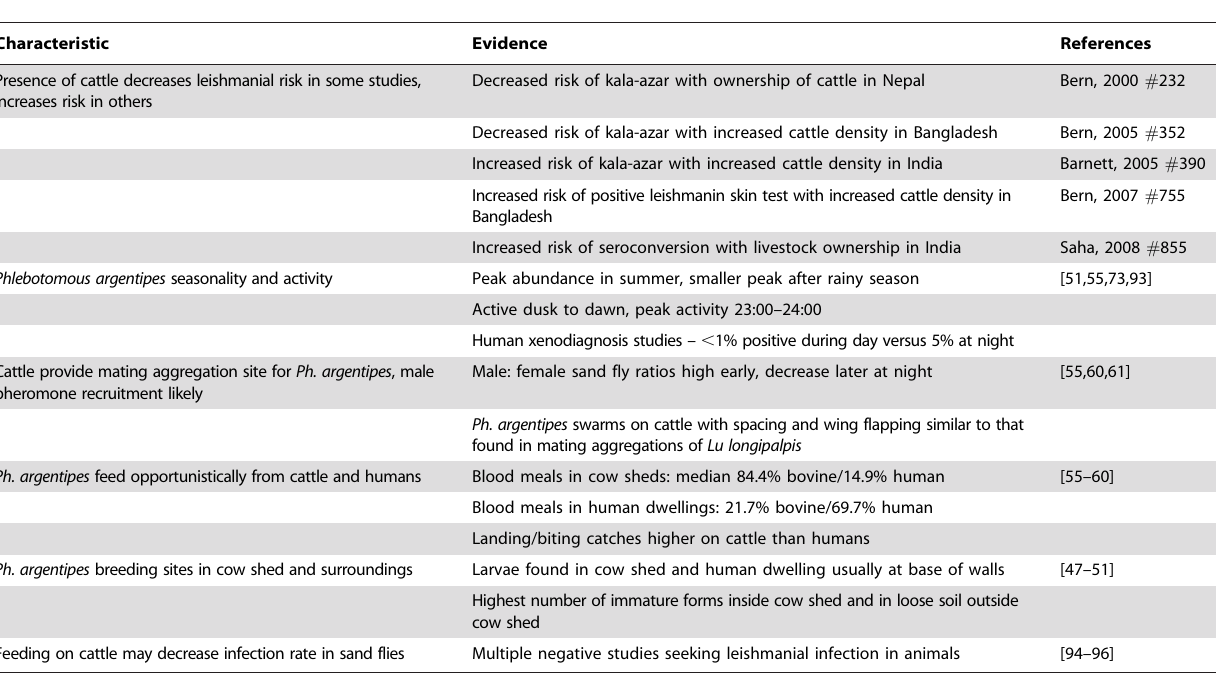
Table 2. Phlebotomous argentipes ecology, cattle and human risk of leishmaniasis.